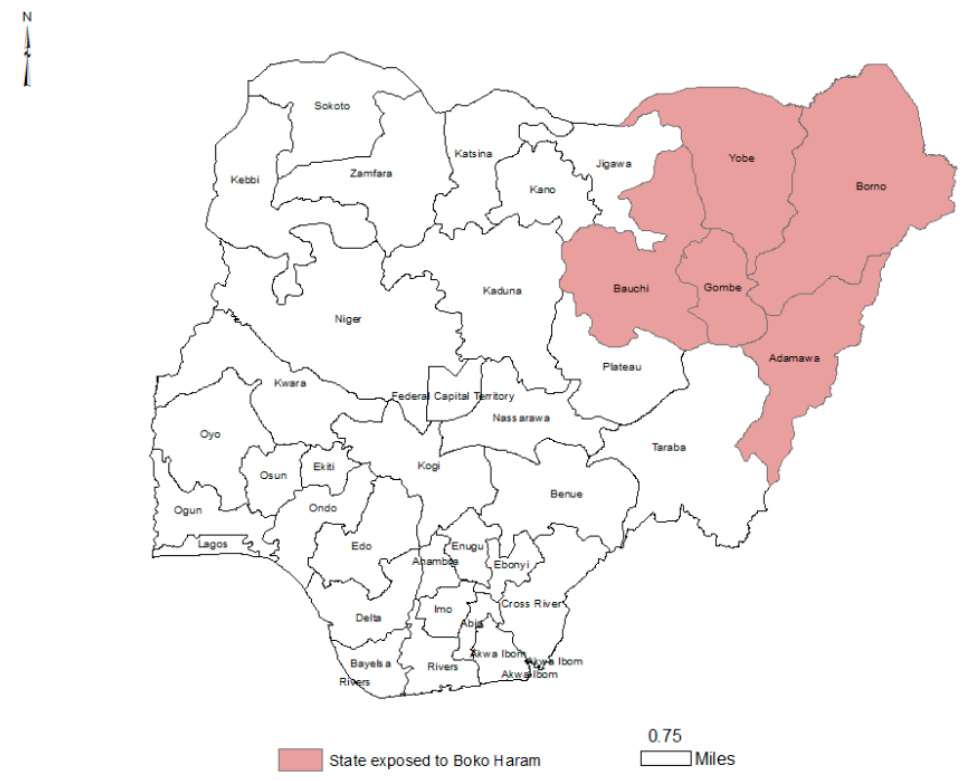
Figure 1. Map of Nigerian States Indicating Boko Haram Presence. (Map generated using ArcGIS 10.7 software, [Esri © , Redlands, CA, USA]).